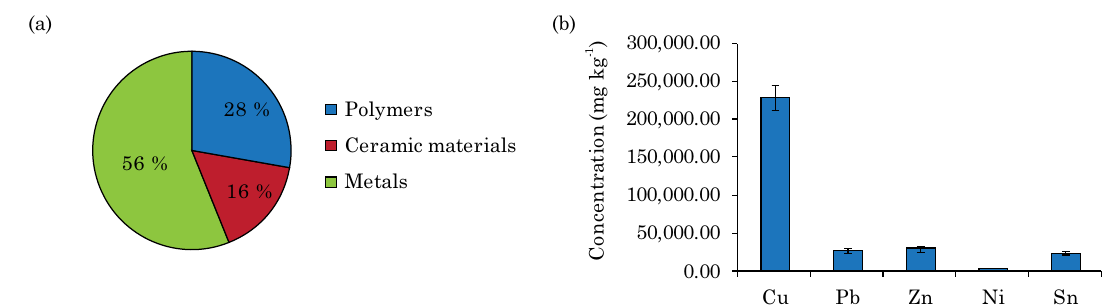
figure 1. Determination of constituents of the electronic waste (eW) (a) percentage of polymers, ceramic materials and metals and (b) concentration of